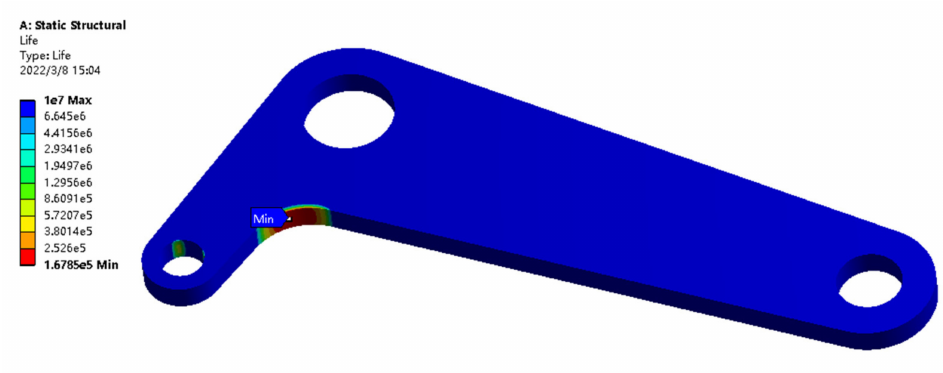
Figure 20. Fatigue life cloud diagram of rotating arm based on the nominal stress